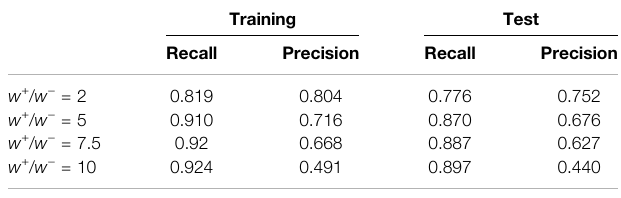
TABLE 2 | Spam Data. The number of examples in the training set is ( N + , N − ) (cid:2) ( 2 , 10 ) . Training Test Recall